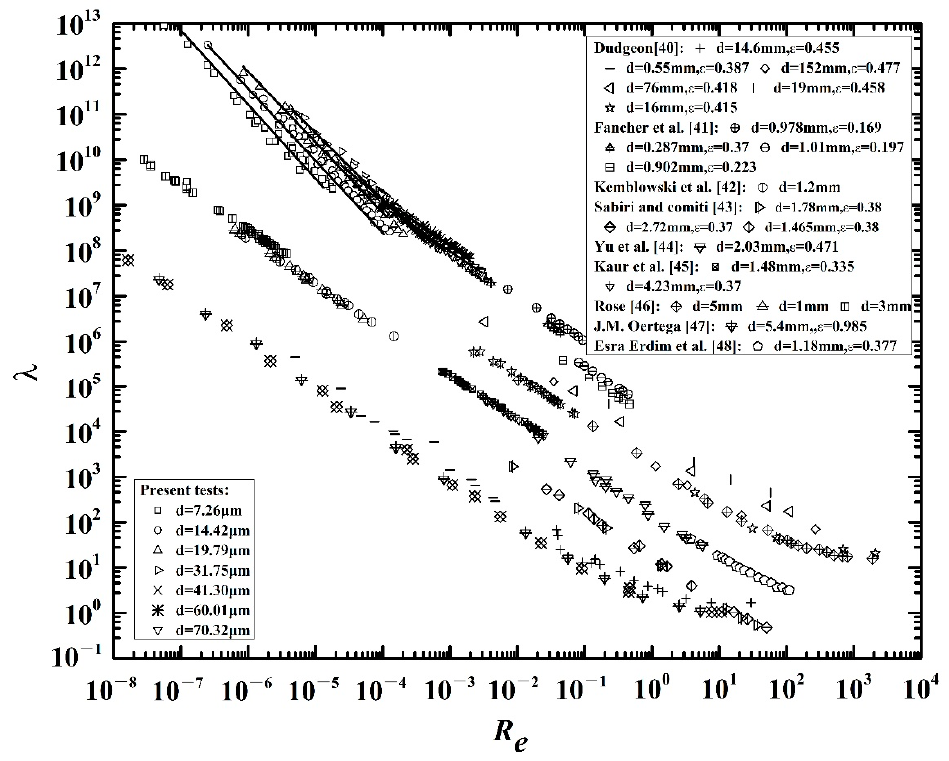
Figure 10. A comparison of resistance factor based on the results obtained in the present study and those reported by other researchers. The values of λ in silty sediments are greater than those in coarse porous media at the same Reynolds number. The slope of λ -R e curve (log-log) for coarse sediments is − 1, while it is variable for silty sediments.